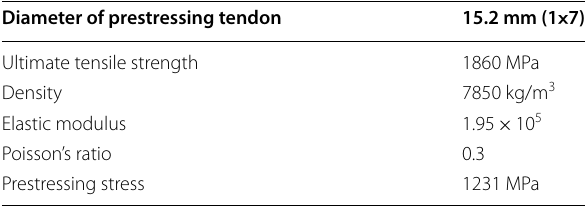
Table 2 Properties of prestressing